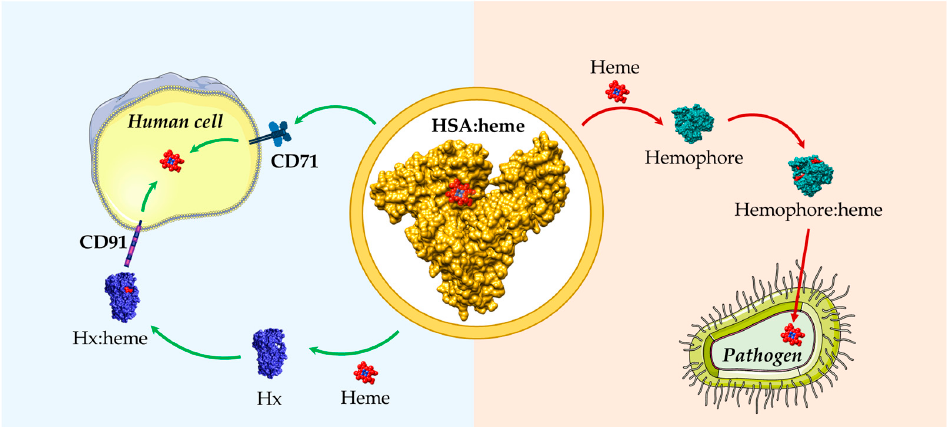
Figure 3. Schematic representation of heme scavenging and delivery by HSA in both human cells and pathogens. HSA can either act as a heme scavenger in human blood reducing the free heme labile concentrations or as a heme donor to pathogens. HSA:heme (PDB ID: 1N5U) [31], Hx:heme (PDB ID: 1QJS) [32], and the C. albicans Csa2 hemophore in complex with heme (Csa2:heme, PDB ID: 4Y7S) [110] have been drawn with UCSF-Chimera [36] . The figure has been partially generated